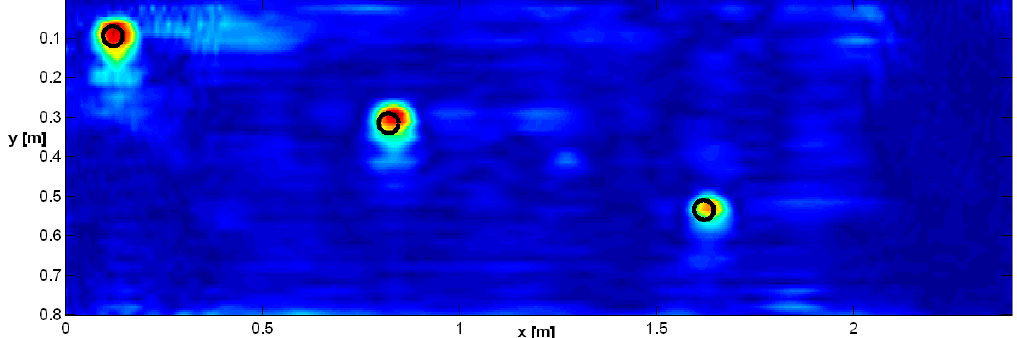
Figure 12. Reconstruction achieved with the shifting zoom, under a data shift of 35 cm.